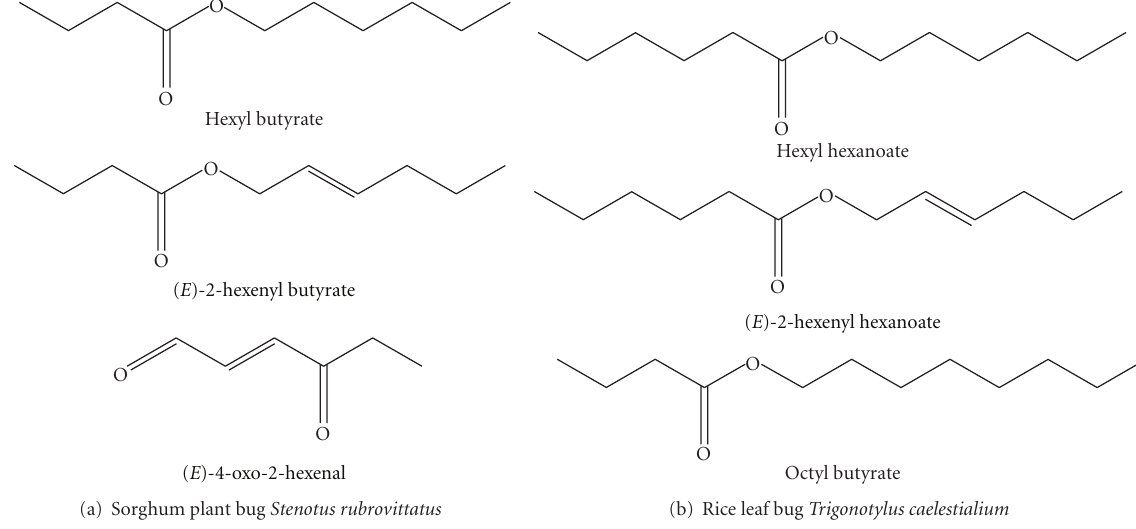
Figure 4: Structures of the pheromone components of Stenotus rubrovittatus (a) and Trigonotylus caelestialium (b).